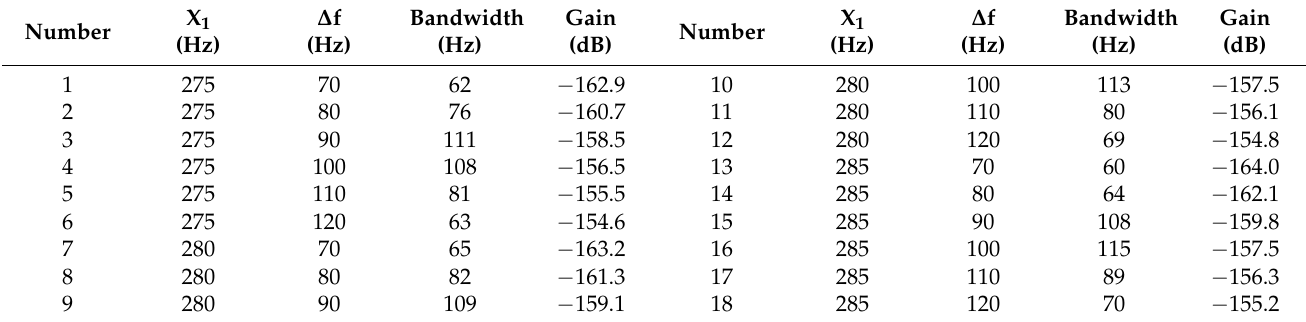
Table 3. Data analysis of gain and